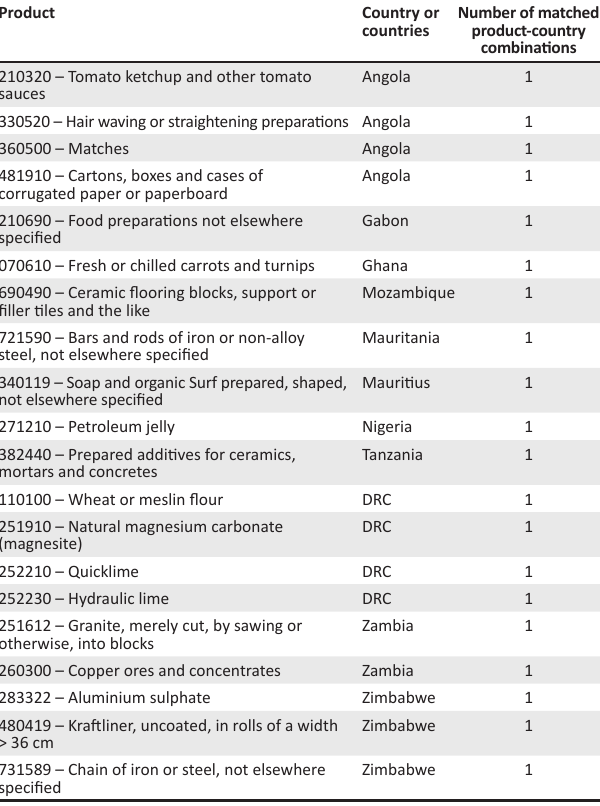
TABLE 5: Matched product-country combinations with underutilised sustained export potential in